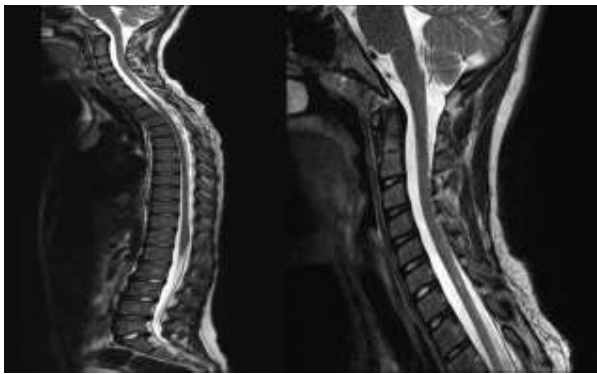
Figure 2. Control examination demonstrating complete resolution of the epidural